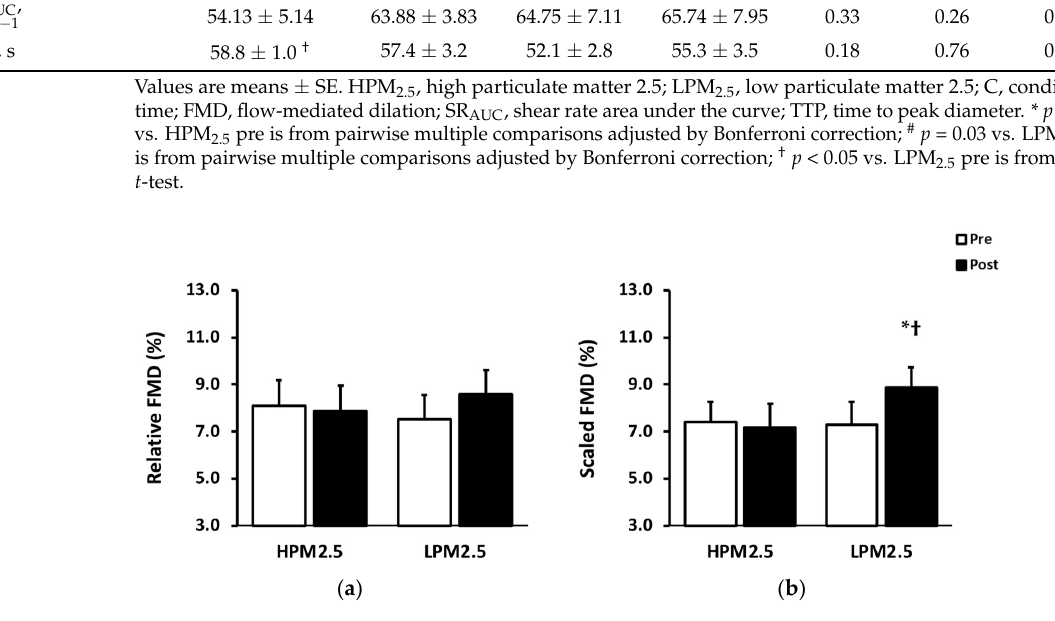
Figure 1. ( a ) Relative flow-mediated dilation and ( b ) scaled flow-mediated dilation at pre-